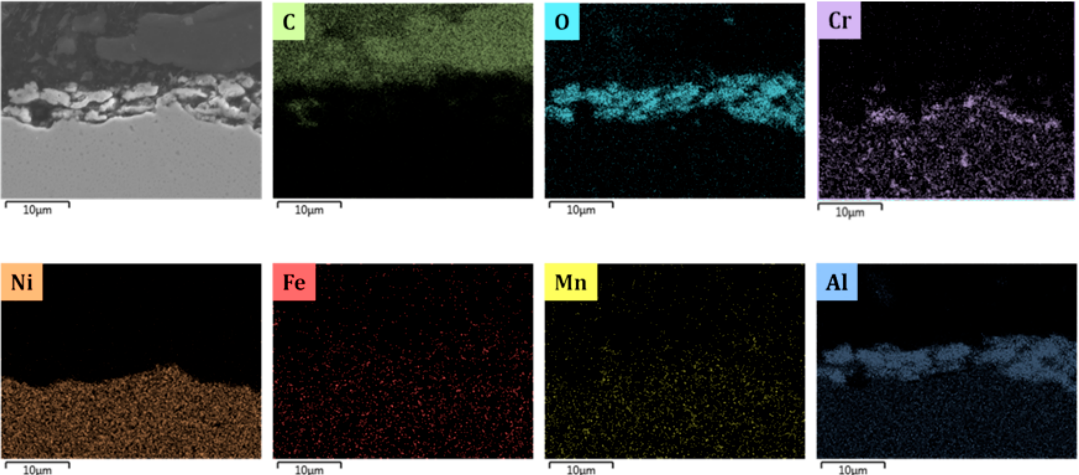
Figure 10. Cross-sectional elemental mappings of a CoatAlloy™ sample subjected to the steam/air pretreatment Magnification: 3000 ×, accelerating voltage: 15 kV.